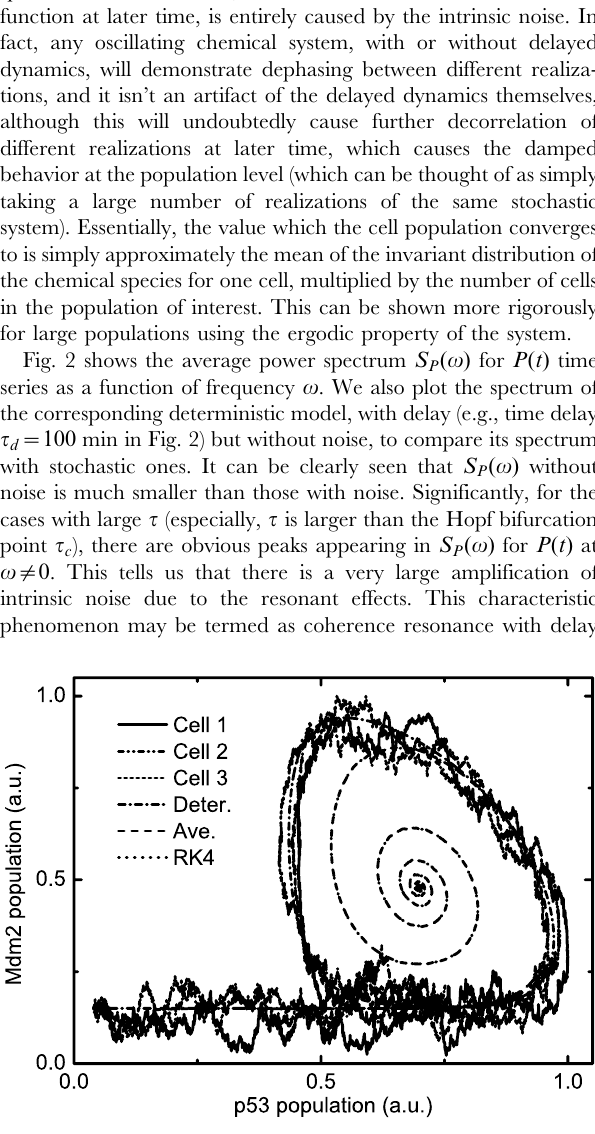
Figure 1. Normalized phase plot ð P ( t ), M ( t ) Þ in 3 individual MCF7 cells following gamma irradiation, deterministic (Deter.) solutions P ( t ), M ( t ) ð Þ , and average (Ave.) populations S P ( t ) T , S M ( t ) T ð Þ in population of cells obtained with the exact DSSA (Ave.) and fourth-order Runge-Kutta (RK4) solutions of Eqs. (12) where the numerical values of C ( t ) and H ( t { t ) are obtained with the exact DSSA. The parameters are chosen as